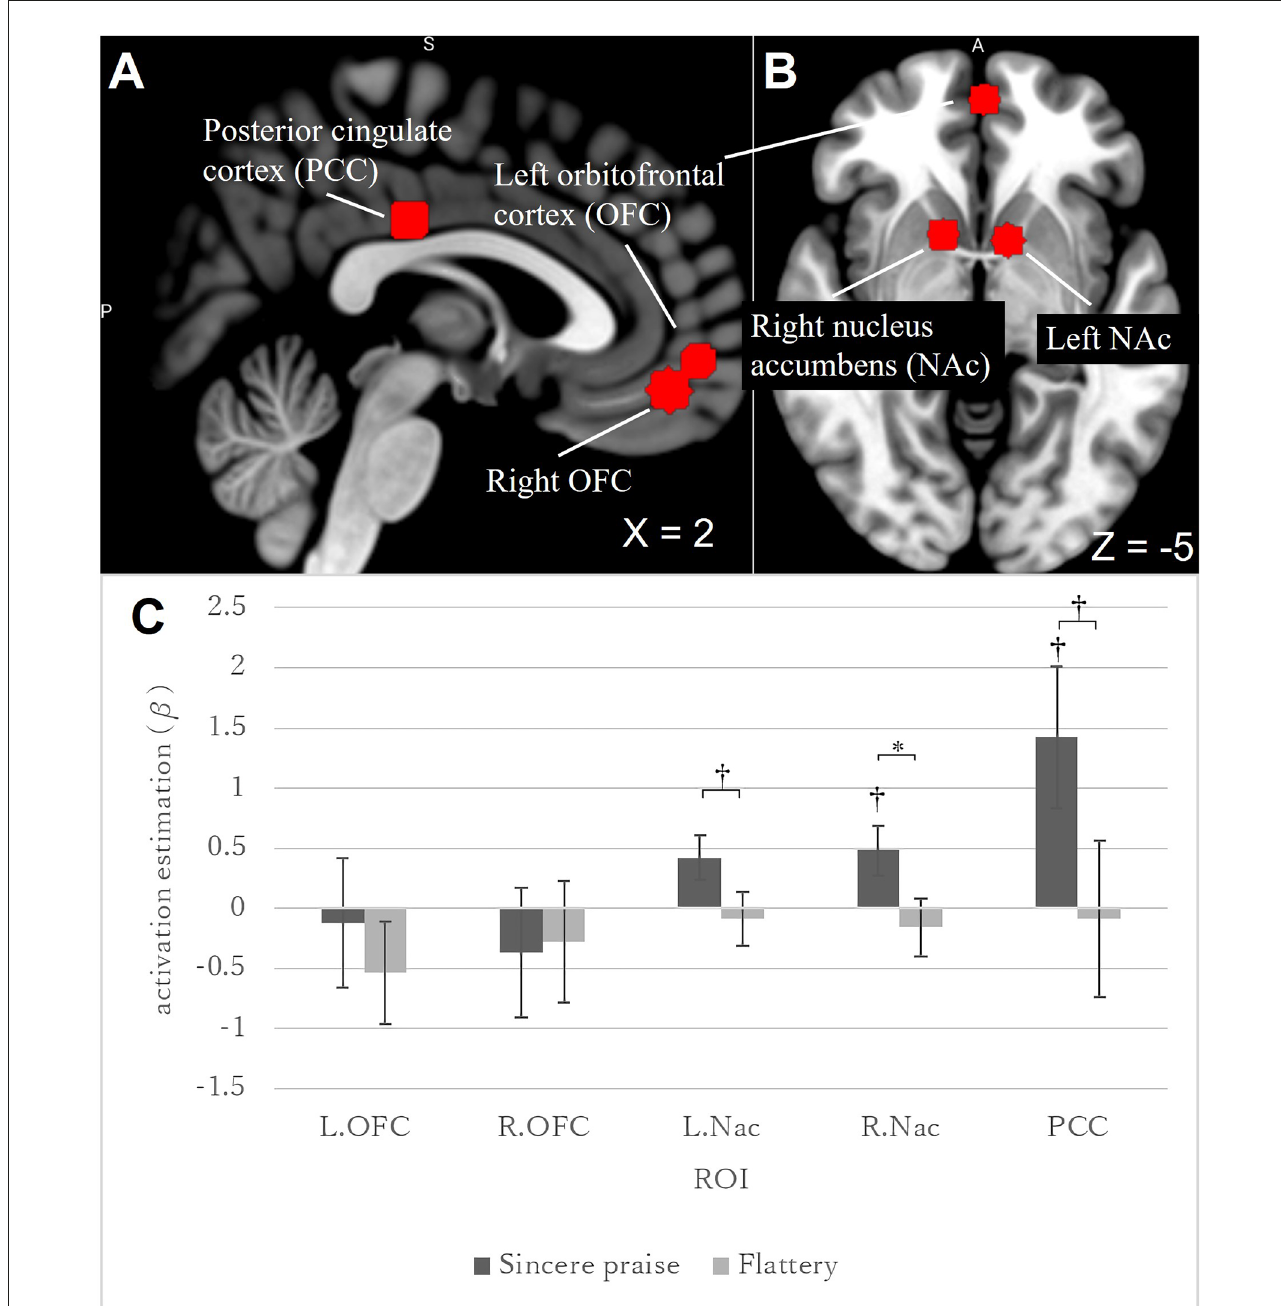
FIGURE2 Regions of interest (ROIs), and brain activities in these ROIs in response to feedback (sincere praise and flattery), compared to the control. A brain slice at the following MNI coordinates: (A) x = 2; (B) z = − 5. ROIs are marked with a red sphere [ (A) PCC and bilateral OFC; (B) bilateral NAc and left OFC], and were produced using Wake Forest University PickAtlas software. Brains were mapped onto the MNI template brain using MRIcroGL (https://www.mccauslandcenter.sc.edu/mricrogl/home). PCC, posterior cingulate cortex; OFC, orbitofrontal cortex; NAc, nucleus accumbens. Bar graph (C) showing the brain activity elicited by sincere praise and flattery in ROIs (bilateral OFC, bilateral NAc, and PCC) with no speed-distinctive contrast [ ∗ : Bonferroni-corrected p -value (0.05/5); † : uncorrected p -value < 0.05]. In the right NAc, brain activity was significantly greater during sincere praise than flattery [Bonferroni-corrected p -value (0.016/5)]. NAc, nucleus accumbens; OFC, orbitofrontal cortices; PCC, posterior cingulate